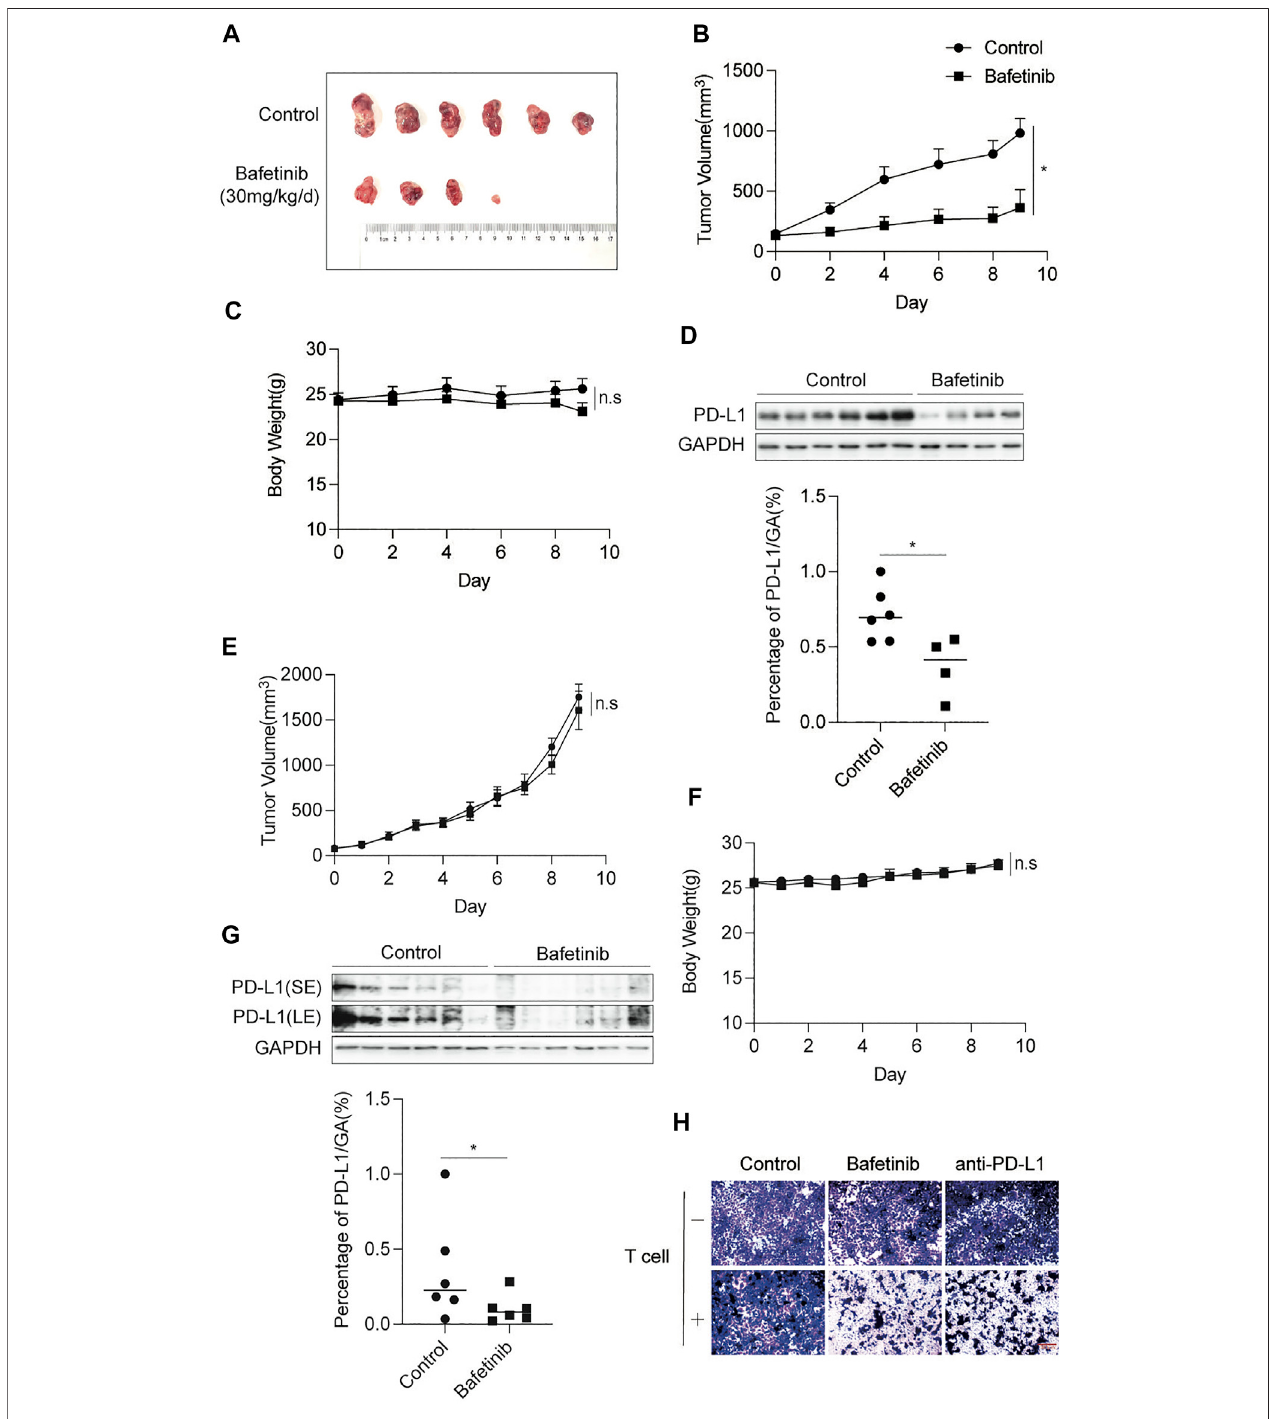
FIGURE 4 | Bafetinib inhibits the expression ofPD-L1 in vivo . (A) Tumor image of Balb/c mice treated with or without Bafetinib (30 mg/kg daily). (B) Tumor volume ofBalb/cmicetreatedwithorwithoutBafetinib(30 mg/kgdaily). (C) ThebodyweightsofBalb/cmiceweremeasuredeveryotherday. (D) ExpressionofPD-L1intumors of Balb/c mice. The relative protein level of PD-L1 in CT26 was quantitatively analyzed below. (E) Tumor volume of immunode fi cient nude mice treated with or without Bafetinib (30 mg/kg daily). (F) The body weights of immunode fi cient nude mice. (G) Expression of PD-L1 in tumors of immunode fi cient nude mice. The relative protein level of PD-L1 in CT26 was quantitatively analyzed below. Bars, mean ± SEM ( n = 6). *, p < 0.05. n. s: not signi fi cant. (H) H292 cells were treated with control Bafetinib (2.5 μ M) or anti-PD-L1. T cells were isolated from peripheral blood and stimulated via anti-CD3/CD28/CD2. Co-incubation was carried out with these treated H292 cells for 8 – 12 h (T cells: Tumor cells = 5:1). After incubation, surviving cells were then fi xed and stained with crystal violet. Sacle bar: 300 μ m.